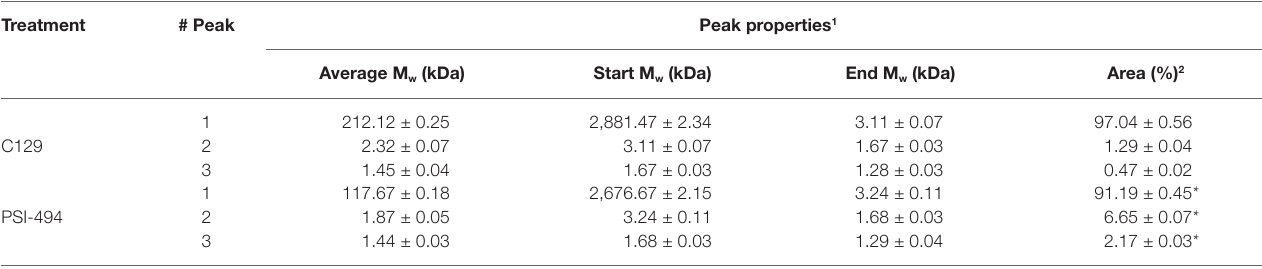
TABLE 2 | Molecular weight distribution of two ANE biostimulant treatments expressed as the average M w of the main peaks, the M w corresponding to the interval of the whole peak or the relative peak area. Treatment